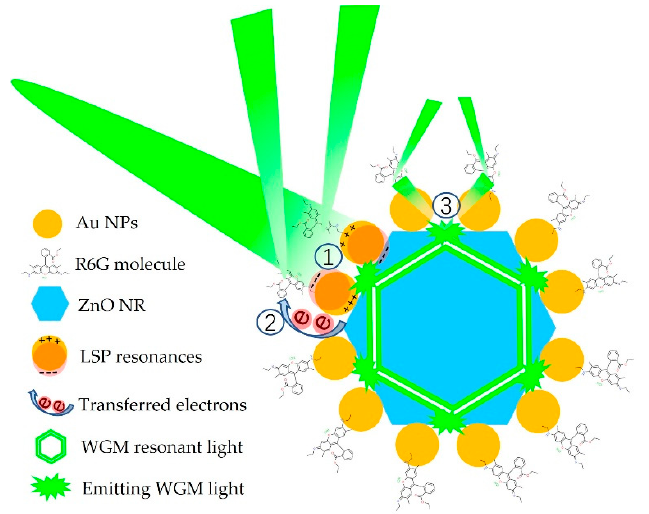
Figure 9. Schematic diagram of multi-effect Raman enhanced mechanism of Au@ZnO-NRs: 1 (cid:13) LSPRs of Au NPs enhance the light field; 2 (cid:13) Transferred electrons from Au to R6G increase the scattering cross section; 3 (cid:13) WGM resonant light emitting from ZnO cavity provides secondary Raman scattering.